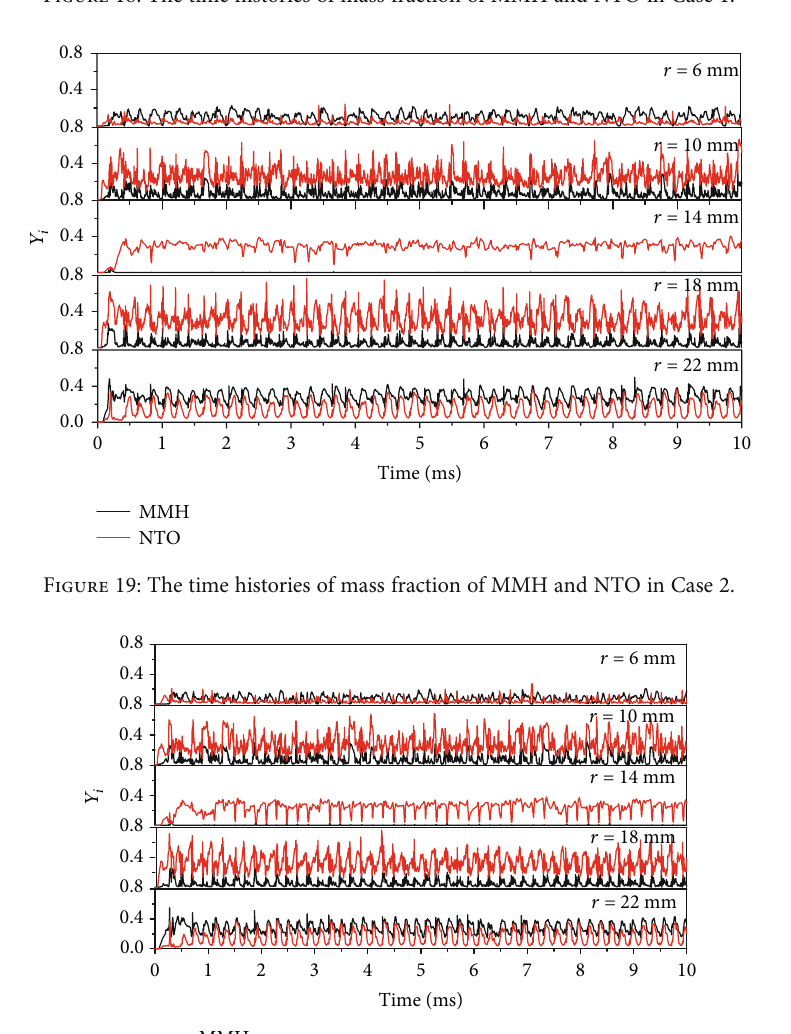
Figure 18: The time histories of mass fraction of MMH and NTO in Case 1.